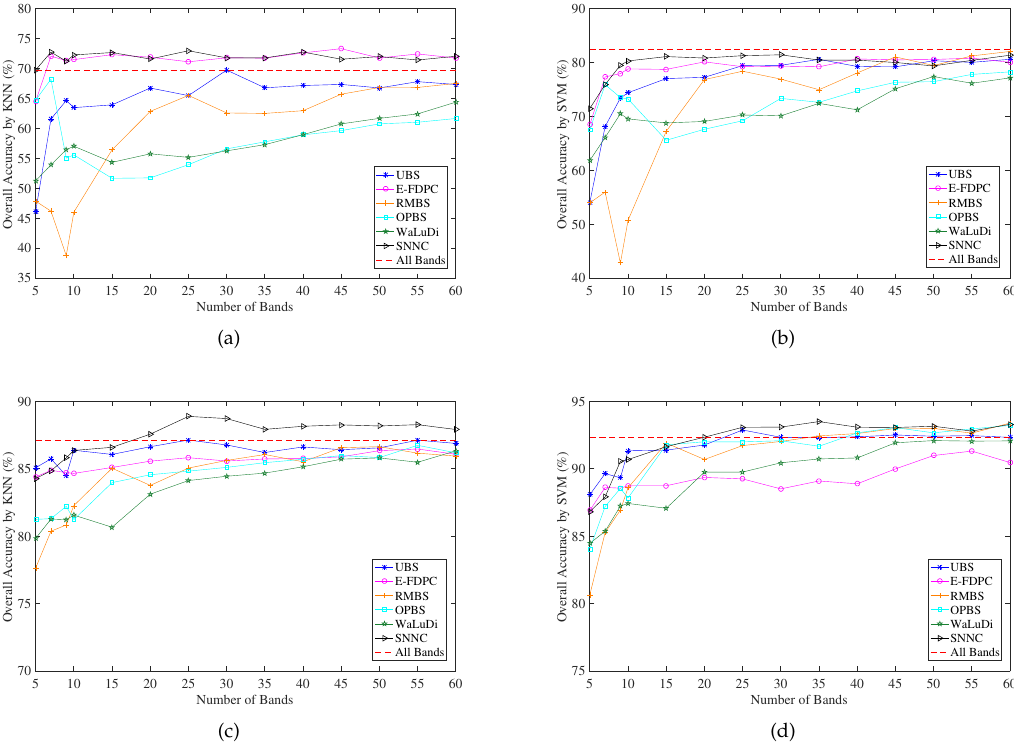
Figure 3. OA for several band selection methods by selecting different number of bands on two data sets. ( a , b ) OA by KNN and SVM on Indian Pines data set, respectively. ( c , d ) OA by KNN and SVM on Pavia University data set,